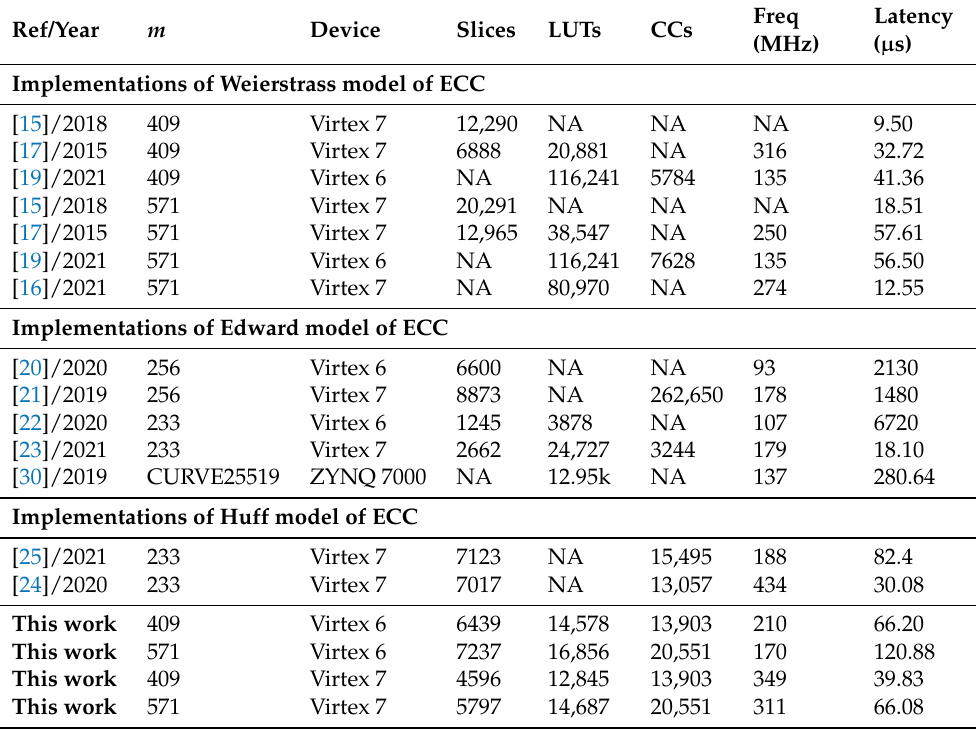
Table 4. Comparison to related PM